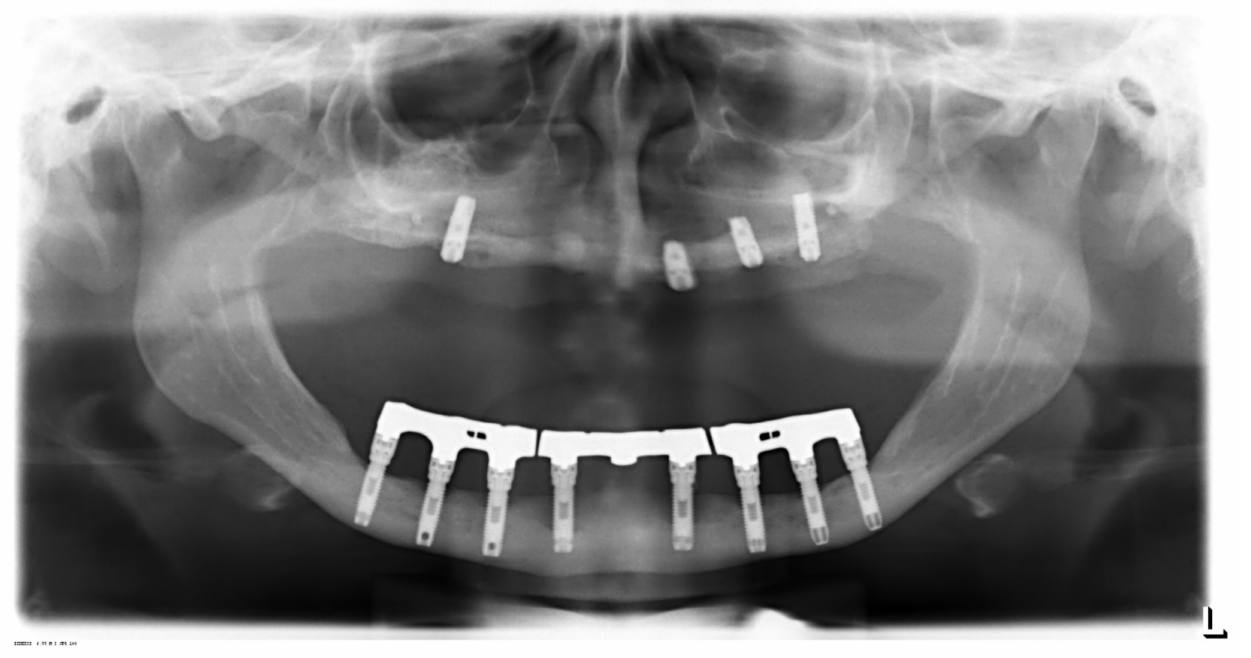
Figure 1. Patient 3 (panoramic radiograph performed in 2008): Eight hollow-screw implants (mandible) inserted in 1992 (16 years in situ); Four Astra ® implants (maxilla) inserted in 2008 (six months in situ), two implants (maxilla) have already been lost.